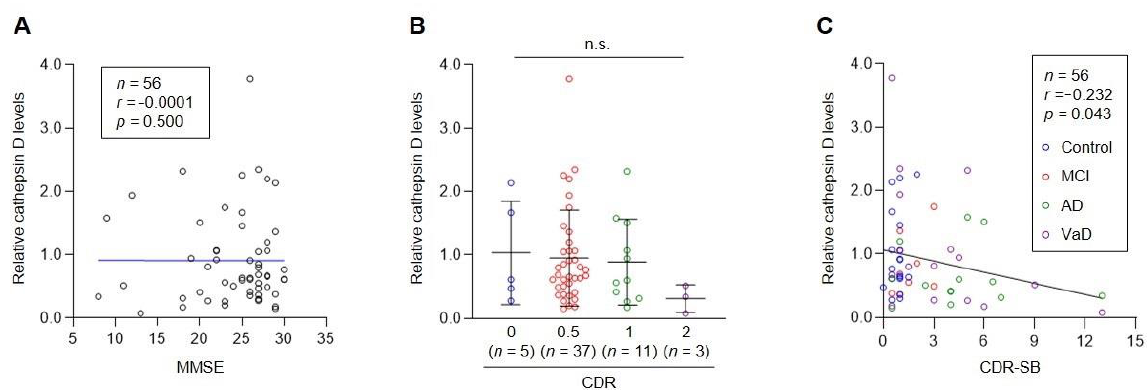
Figure 4. The level of plasma cathepsin D negatively correlates with CDR-SB scores. ( A – C ) Correlations of plasma cathepsin D levels with MMSE scores ( A ), CDR scores ( B ), and CDR-SB scores ( C ) were analyzed. Each dot indicates the cathepsin D level of each control or patient plasma. ( A , C ) Pearson correlation coefficient (r) and p -value of linear regression are shown in each panel. ( B ) Mean ± SD is illustrated as a horizontal line in each group. n.s., not significant (Kruskal–Wallis